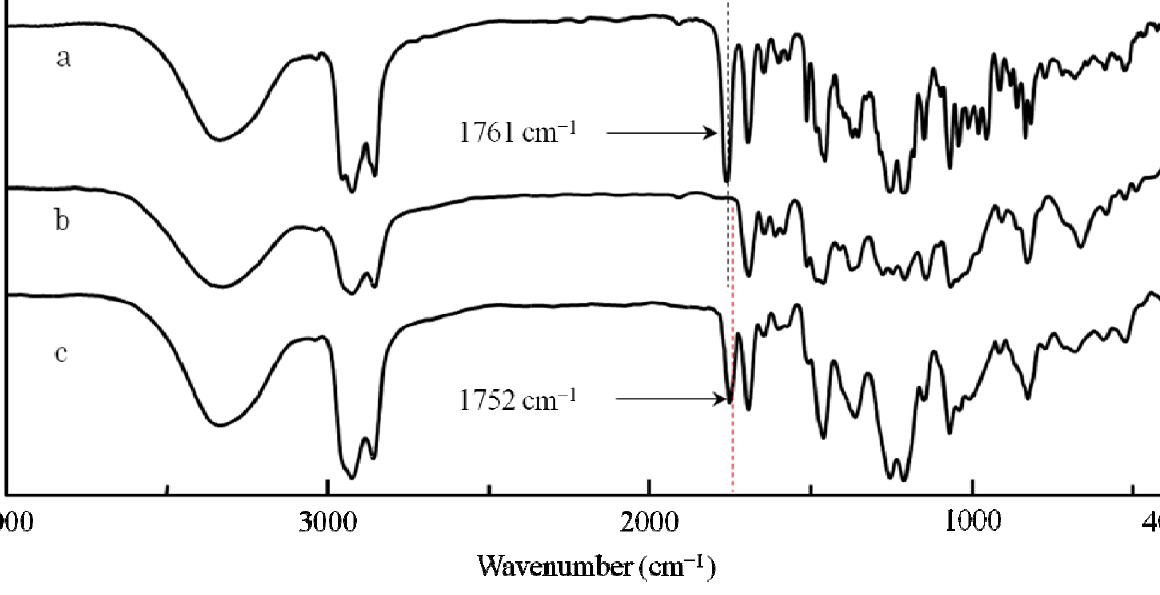
Figure 6. CD and UV-Vis spectra of (a) poly( 1 ), (b) poly( de -1 ) and (c) poly( re -1 ) in membrane